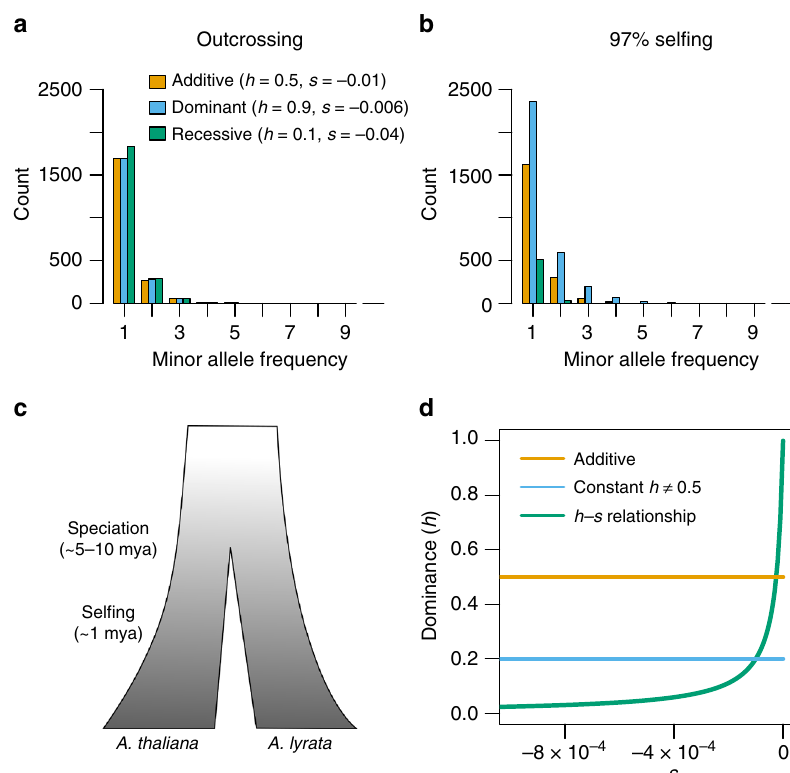
Fig. 1 The effect of dominance and mating system on the site frequency spectrum (SFS). a The SFS from an outcrossing species simulated under different DFEs and h values. Note that different combinations of DFEs and values of h yield similar SFS. b The SFS for the same DFEs and values of h as in a for a highly sel fi ng species. Differences in h result in large differences in the SFS in sel fi ng species, allowing us to reliably co-estimate the DFE and h . c A schematic of the species history between A. thaliana and A. lyrata . d Examples of the relationship between h and s under the three different models of dominance tested